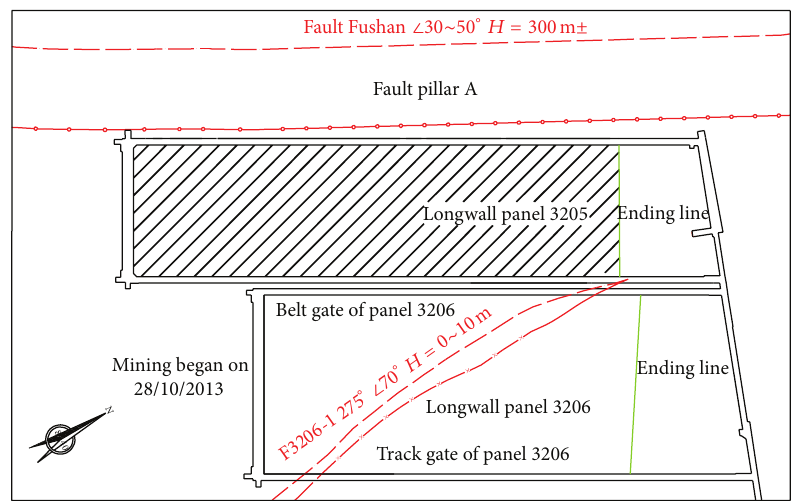
Figure 12: Gateway layout of the mining 3206 area.